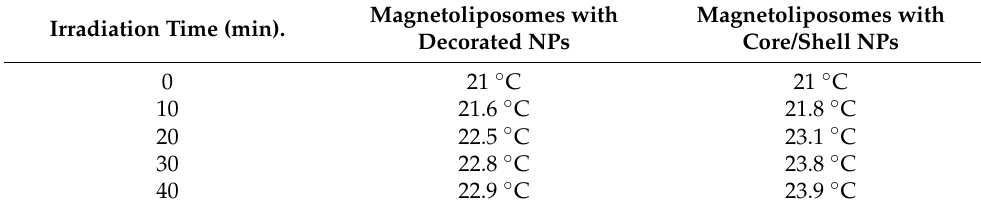
Table 6. Local temperature as determined by Nile Red absorption changes. Magnetoliposomes with Irradiation Time (min). Decorated NPs